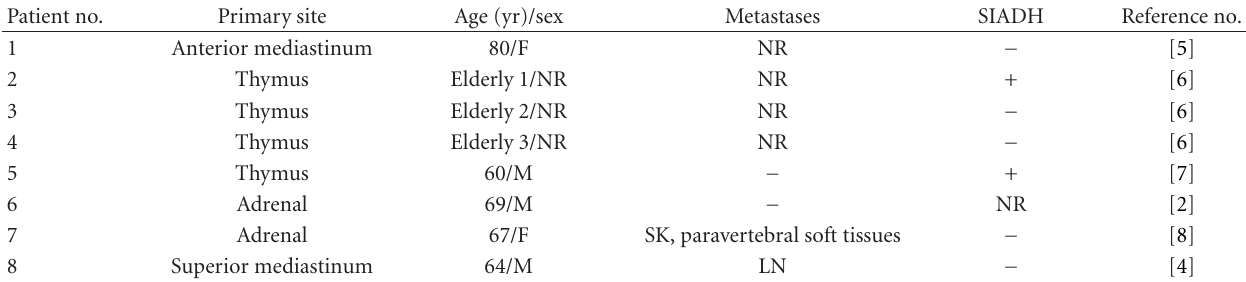
Table 1: Clinical characteristics of the literature patients.